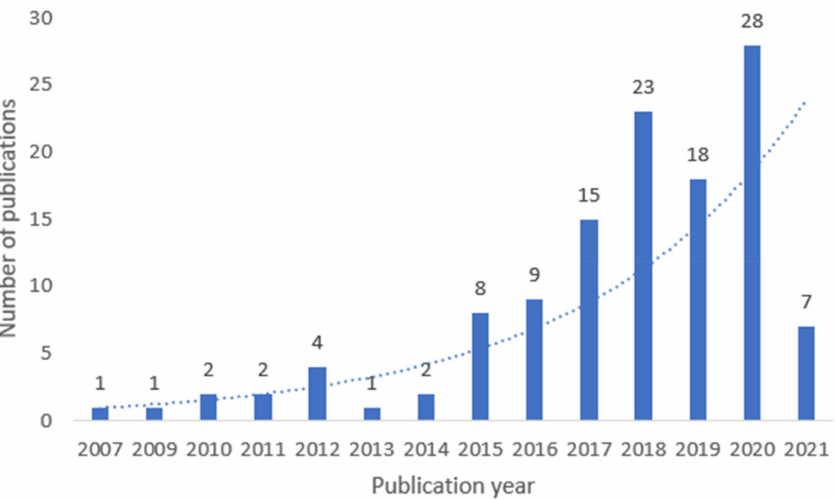
Figure 1. Publishing trends in remanufacturing